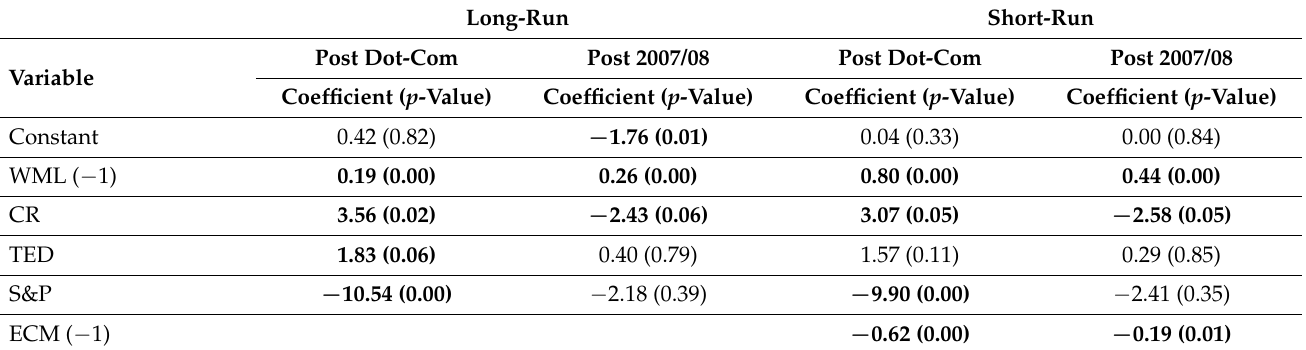
Table 24. Long-run ARDL model and short-run error correction model for WML (Non-Recession). Long-Run Short-Run Post Dot-Com Post 2007/08 Post Dot-Com Post Variable